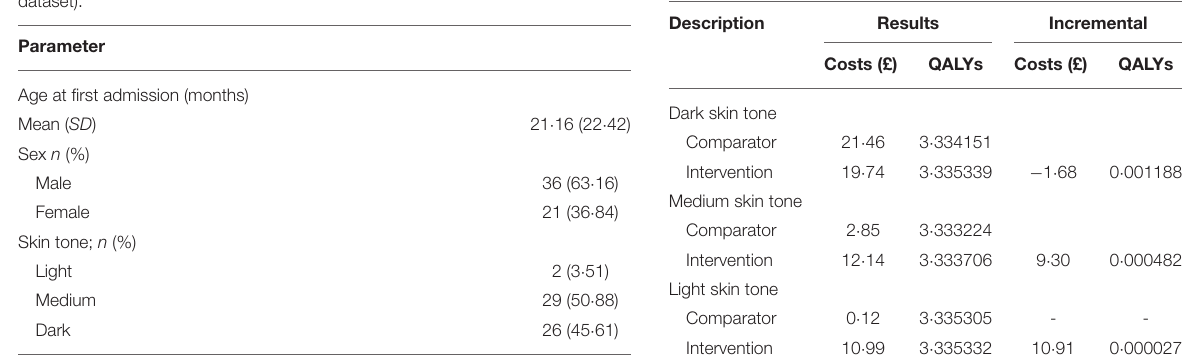
TABLE 7 | Base case analysis results (deterministic